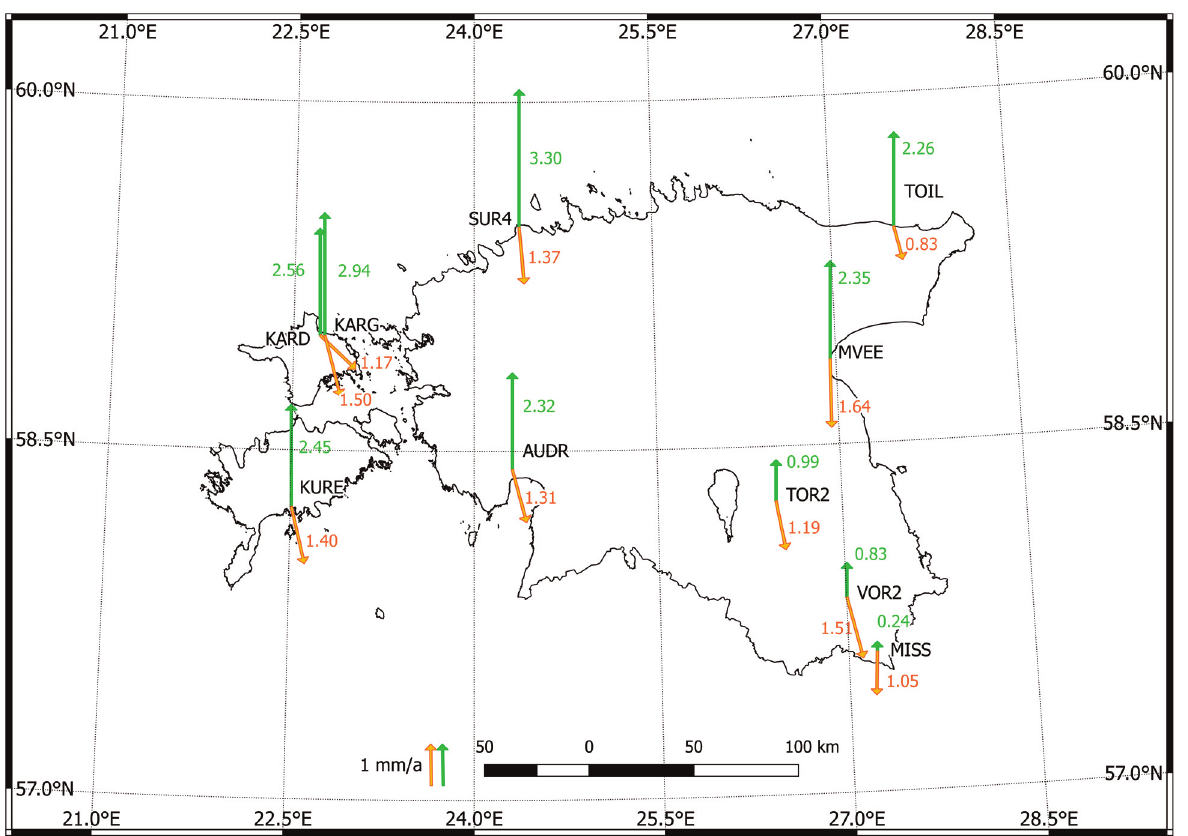
Fig. 6. The intraplate velocities ( ν obs – ν ITRF 2008– PMM ) of the Estonian CORS in horizontal (orange) and vertical (green) directions, according to Kall et al. (2019). Units mm/a. Table 6. Velocities (ν) between periods 1997–2008 and 2008–2017 in North (N), East (E) and Up (U) directions, standard deviations of velocities (σ at 99.9% confidence level) and probability of significance of velocity differences ( p ) of 1st-order points of GRN. Probabilities marked with grey background are statistically significant at the level α = 0.001. Unit is mm/a Name of the